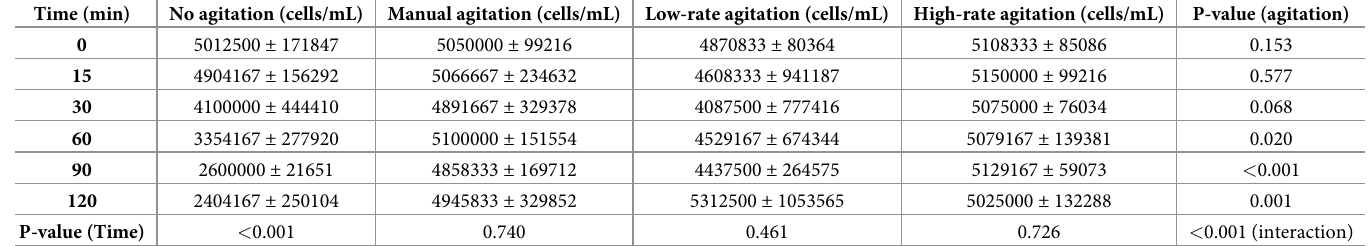
Table 3. Mean and standard deviation of cell concentrations at each time point and agitation condition. Simple main effects were analyzed for each time point and agi- tation condition. Statistical analysis was done by two-way ANOVA. Time (min)